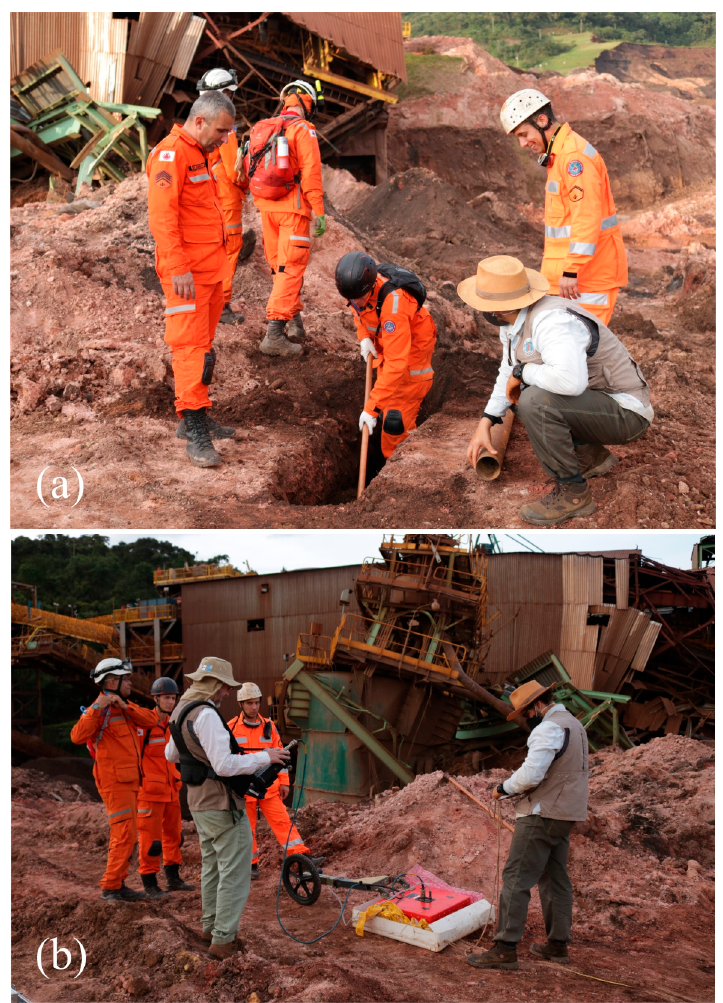
Figure 5. ( a ) Excavation of a trench for the placement of a metal pipe at a known depth. ( b ) GPR profile acquisition on the metal pipe installed in ( a ) to calculate the propagation velocity of the GPR electromagnetic wave.